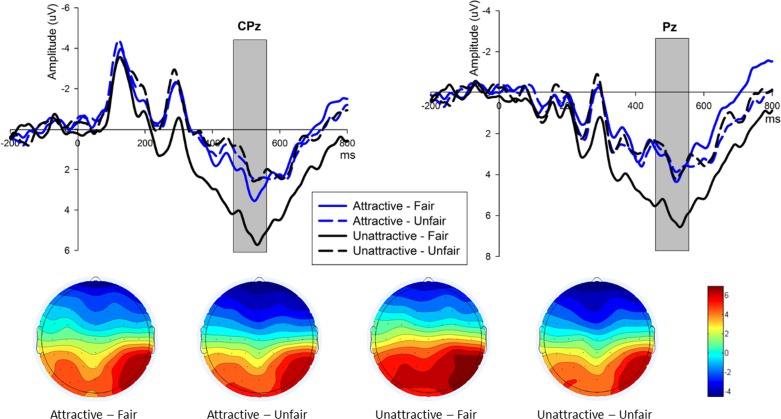
The ERP grand-average waveforms and topographic map of P300.(A) CPz and Pz were selected for P300 (shaded 460–560 ms) waveforms to compare fair and unfair offers in the two face conditions. (B) The bar for four offer conditions of P300 topographic map ranges from -4.5μV to 6.5μV.